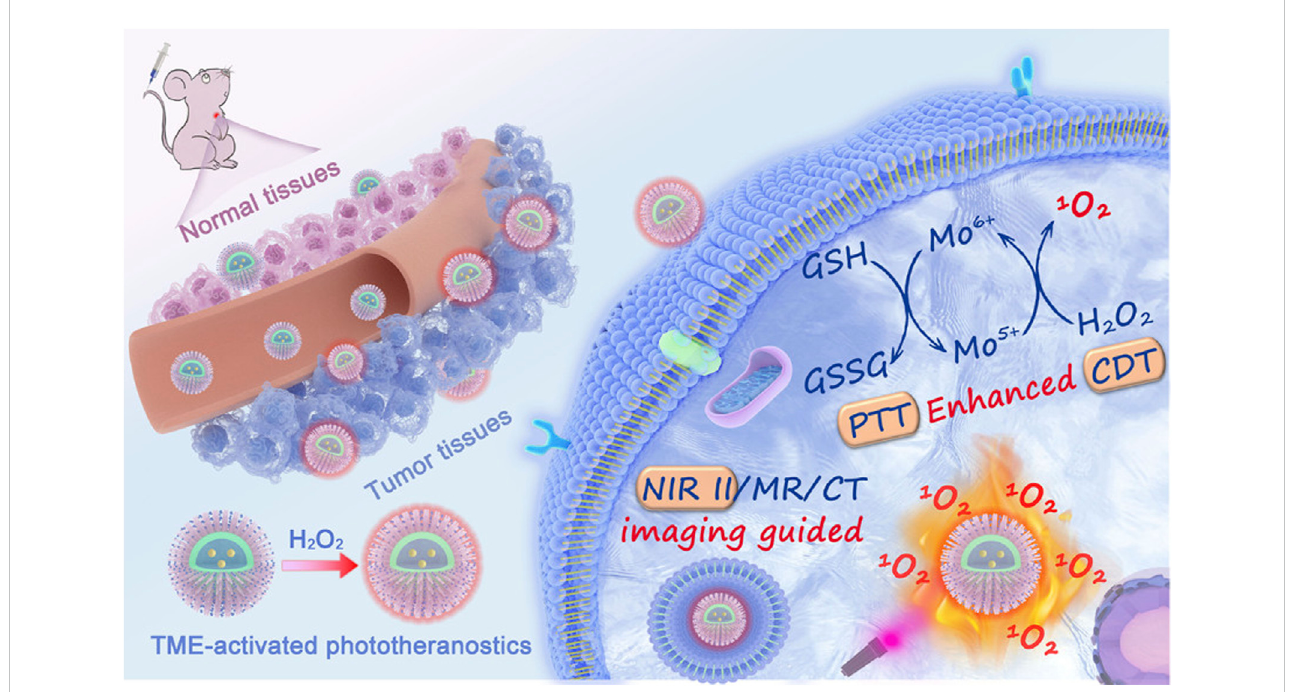
FIGURE 8 Illustration of the Preparation Procedure and Working Mechanisms of the DCDMs. Reproduced with permission from (Dong et al., 2020b) Copyright (2020) American Chemical Society.